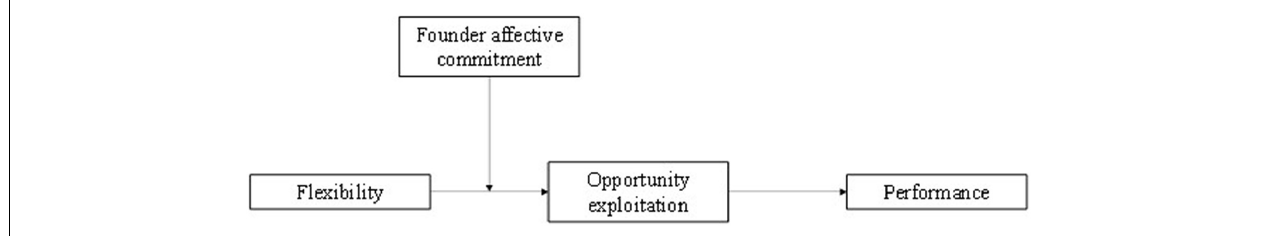
FIGURE 1 | Mediation model of flexibility, opportunity exploitation, and performance, moderated by founder affective commitment.